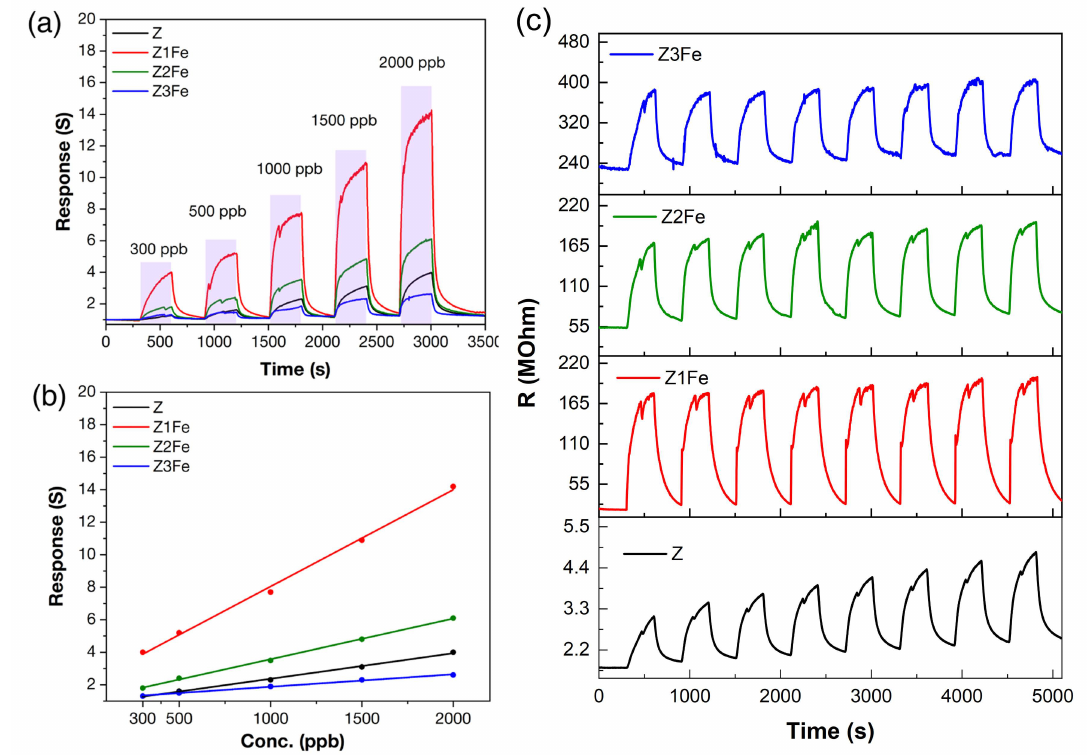
Figure 10. Sensitivity to 300–2000 ppb NO 2 ( a ); dependences of response from NO 2 concentration ( b ) and reproducibility of the signal when detecting 500 ppb NO 2 ( c ) at 175 ◦ C operating temperature and 0%RH for ZnO/Fe 2 O 3 thin